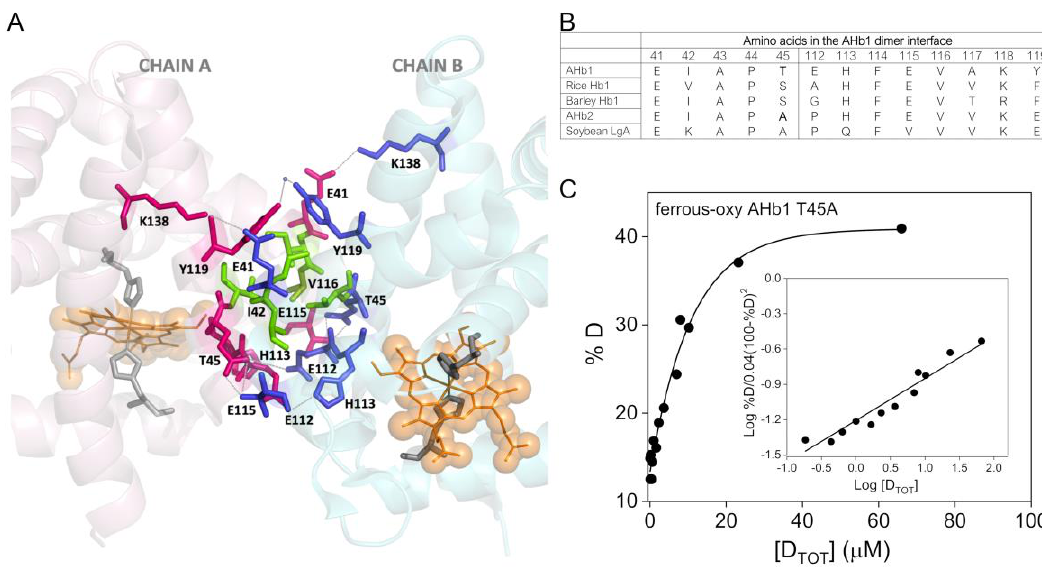
Figure 3. Dimeric interface of AHb1. ( A ) View of the dimeric protein showing the interface region in AHb1 (PDB 3ZHW). Chain A is in light pink and chain B is in light blue. Key residues involved in hydrogen bonding (dotted lines) and Y119-Y119 interaction (by water molecules) are labelled and represented as pink sticks (chain A) or blue sticks (chain B). Residues I42 and V116 in each monomer forming the hydrophobic cluster are in green. The heme molecules are represented as lines and spheres colored in orange. Distal and proximal histidine residues configuring the heme cavity are in gray sticks. ( B ) The AHb1 dimer interface regions aligned with homologous regions from other plant hemoglobins. ( C ) Representative dimer-monomer dissociation curve of ferrous-oxy AHb1 T45A at pH 7.2 in 150 mM Tris-acetate buffer pH 7.5. [D TOT ] represents the total AHb1 T45A concentration (in dimer equivalents) and %D represents the percentage of protein that is actually dimer at various AHb1 T45A concentrations. Inset shows the plot of log %D/0.04 (100 − %D) 2 versus log [D TOT ] according to Manning et al. [28]. Procedures used for evaluation of K d values are described in detail in Section 2.5.